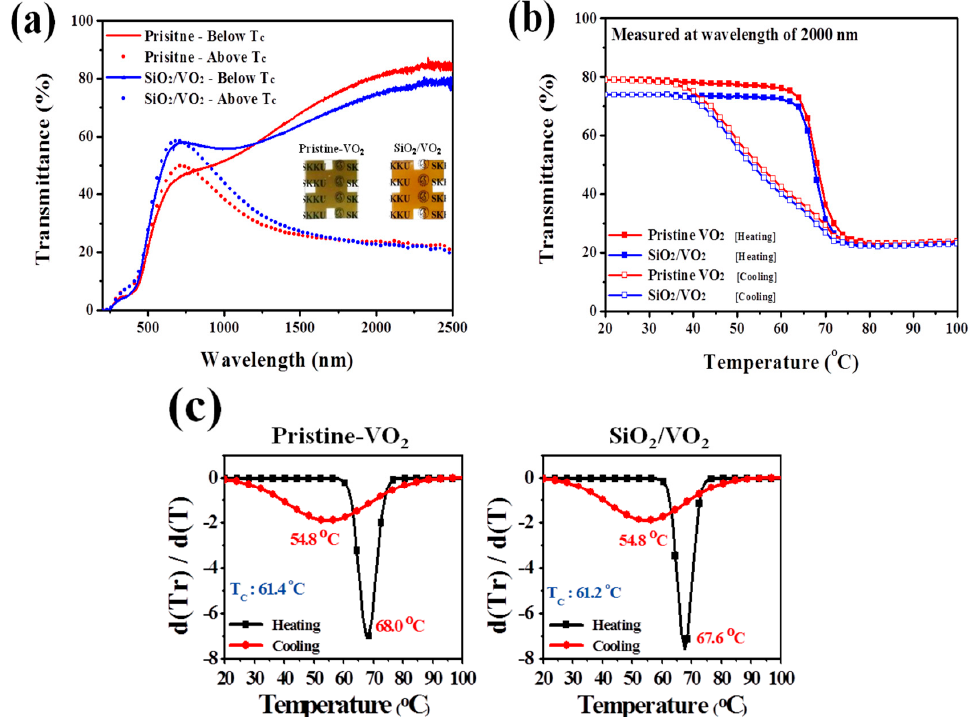
Figure 3. Transmittance spectra ( a ); hysteresis loops at 2000 nm ( b ) as well as corresponding d(Tr)/d(T)&T curve ( c ) for pristine VO 2 and SiO 2 /VO 2 thin films. The inset images in ( a ) correspond respectively to photographs of the pristine VO 2 film (left) and VO 2 /SiO 2 film (right). In ( a ), solid line measured at 25 °C, dashed line at 100 °C.